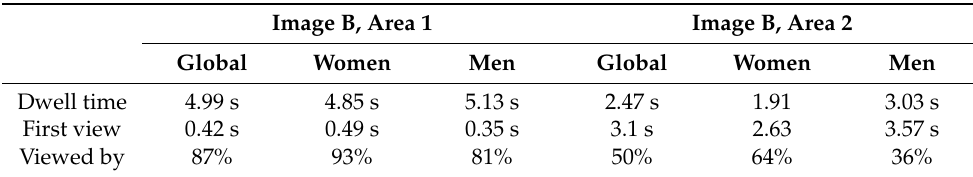
Table 4. Gender analysis. Image B.